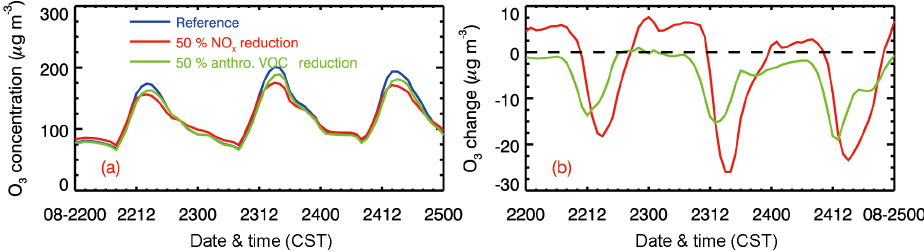
Figure 16. Diurnal profiles of (a) O 3 concentrations and (b) O 3 changes averaged in Xi’an and surrounding areas caused by a 50% reduction in anthropogenic NO x and VOC emissions, respectively, from 22 to 24 August 2013. Blue line: the reference simulation; red line: the simulation with a 50% reduction in anthropogenic NO x emissions; green line: the simulation with a 50% reduction in anthropogenic VOC